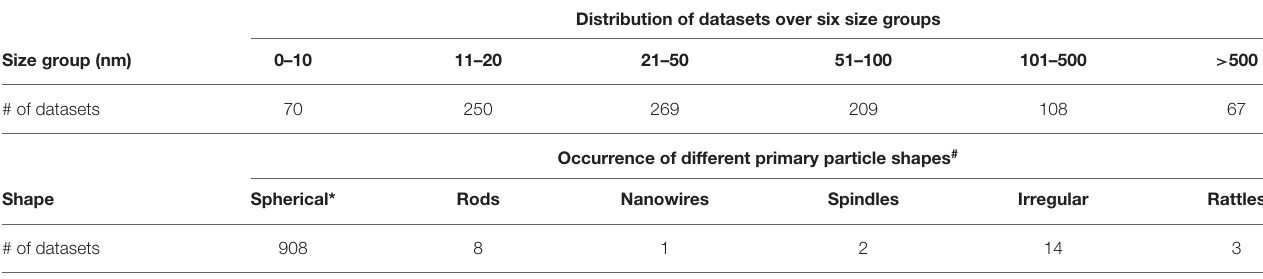
TABLE 4 | Distribution of the datasets over the size classes and different material forms.